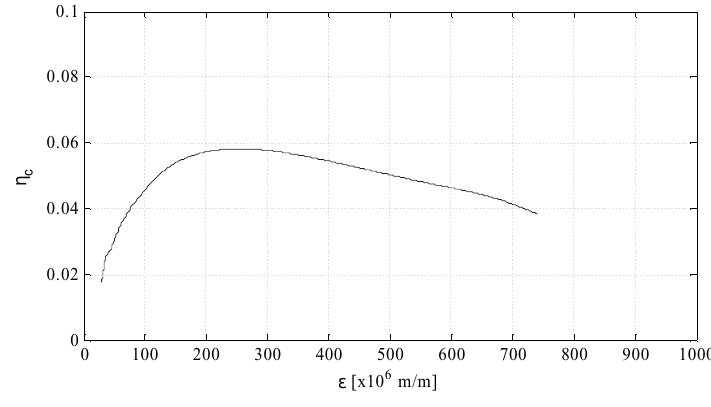
Fig. 18. Loss Factor of Magnesium Aluminate